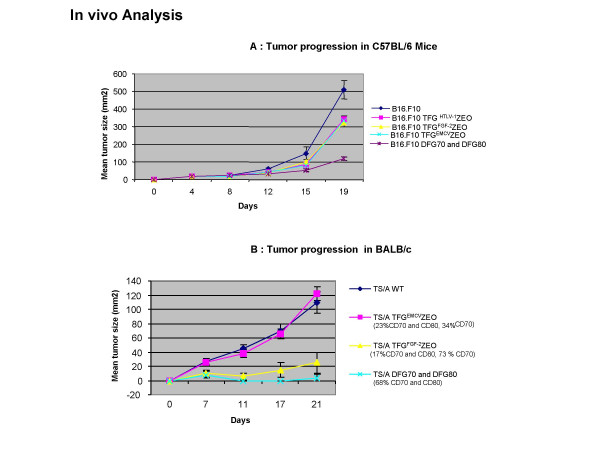
Effects of CD70 and CD80 co-expression by single transduced tumor cells on tumor growth in an established model. 4A: 105 B16.F10 wt (control cells), or CD70 and CD80 double transduced B16.F10, or CD70 and CD80 single transduced B16.F10 were injected s.c. on day 0 into female C57BL/6 mice. 4B: 105 TS/A wt (control cells), or CD70 and CD80 double-transfected TS/A, or CD70 and CD80 single-transfected TS/A were injected s.c. on day 0 in female BALB/c mice. Tumor growth was monitored twice a week. The results are expressed as mean size (mm2) of tumors from groups that each contain five mice ± SD. The data represent mean +/- SD of a single experiment representative of three.pouet